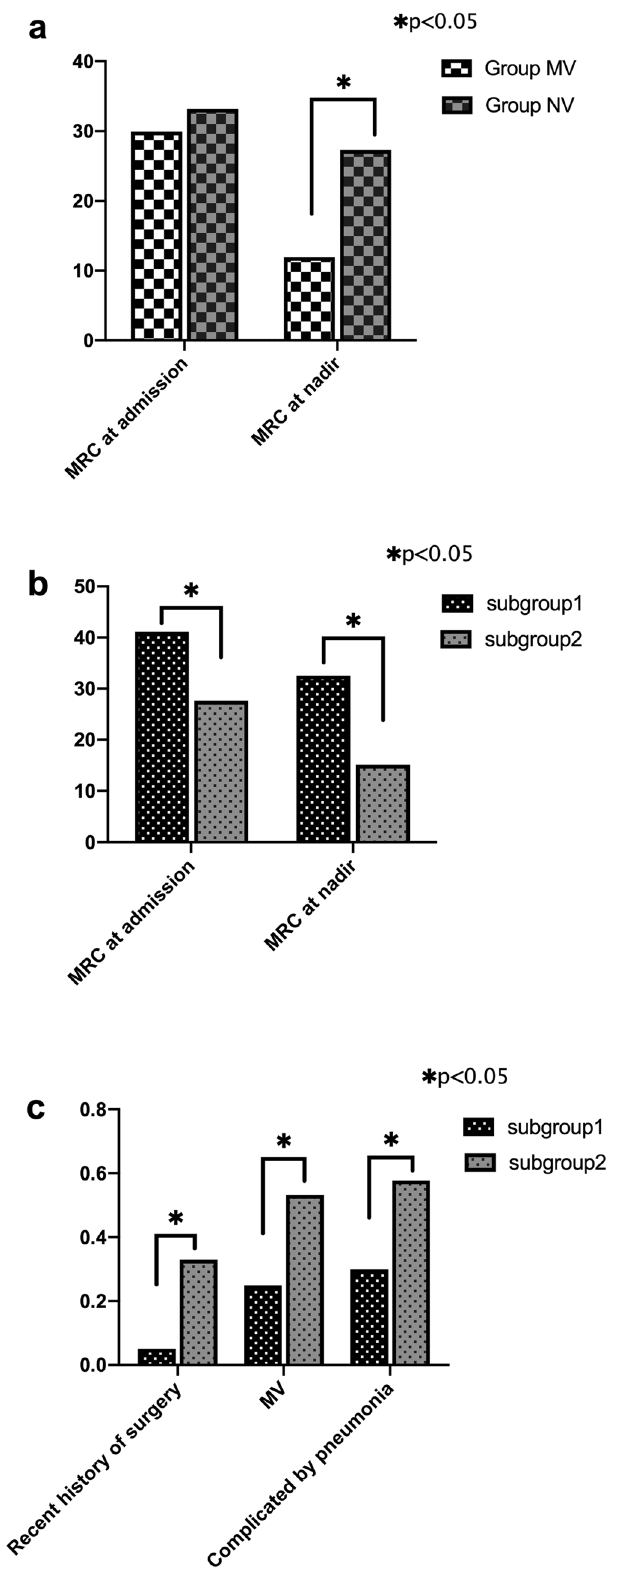
Figure 2. Comparisons between Group MV and Group NV, Subgroup 1 and Subgroup 2. ( a ) MRC at nadir in Group MV were lower than Group NV ( p < 0.05), but MRC at admission had no difference between Group MV and Group NV in statistic. ( b ) In Subgroup 1, MRC at admission and at nadir were both higher than Subgroup 2(both p < 0.05). ( c ) Recent history of surgery, requiring MV and complicated by pneumonia were totally lower in Subgroup 1 than Subgroup 2( p <